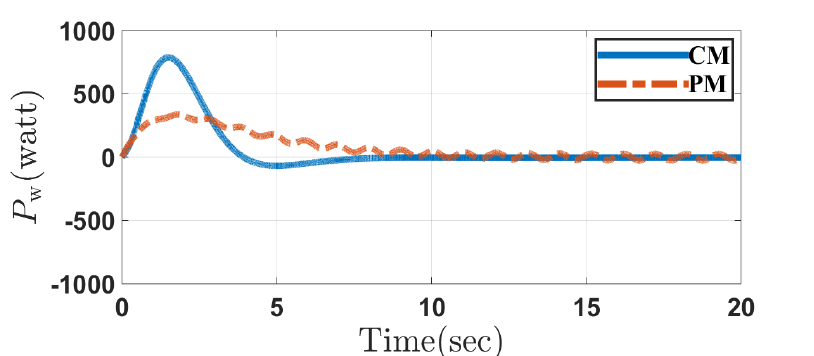
Figure 8. Input power of wheels in the conventional method (CM) and the proposed method (PM) in Case 1.